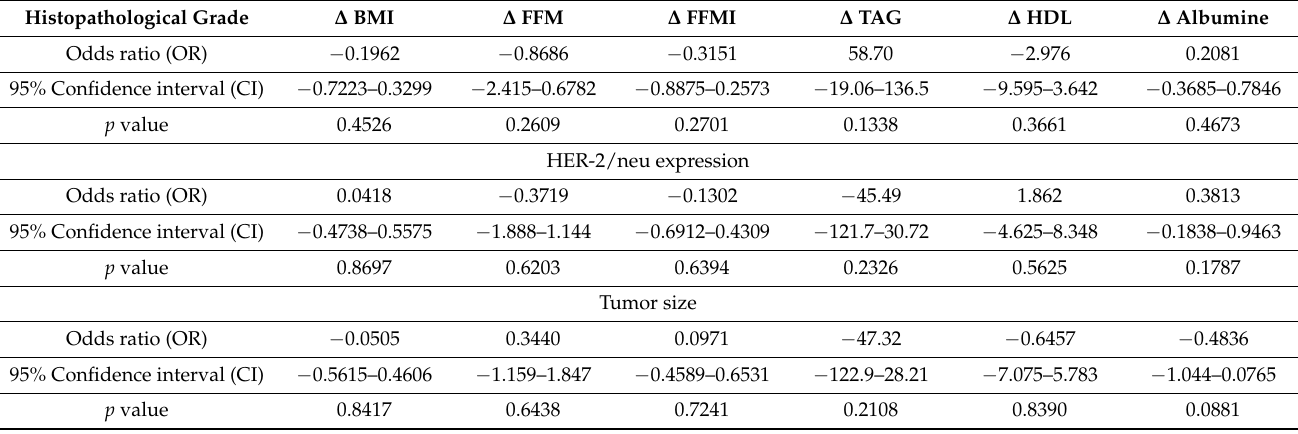
Table 4. Multivariate regression assessing the influence of age and clinicopathological factors on changes in biochemical and anthropometric parameters during chemotherapy in the matched supplemented